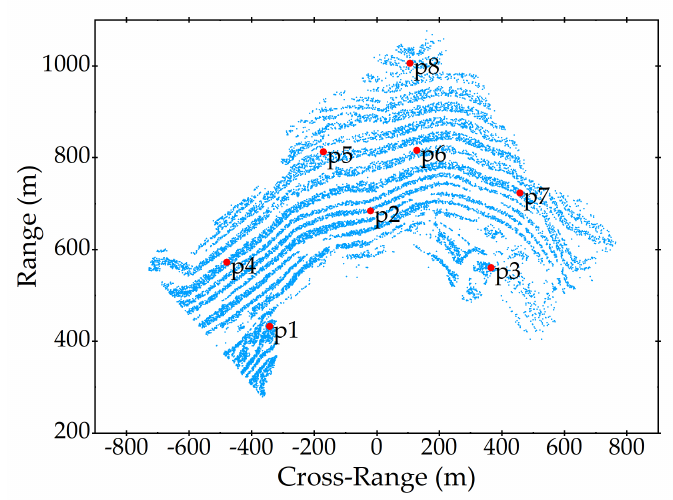
Figure 2. Permanent scatterers (PSs) selection result, p 1 – p 8 are the reference PS (RPS) points for phase analysis.